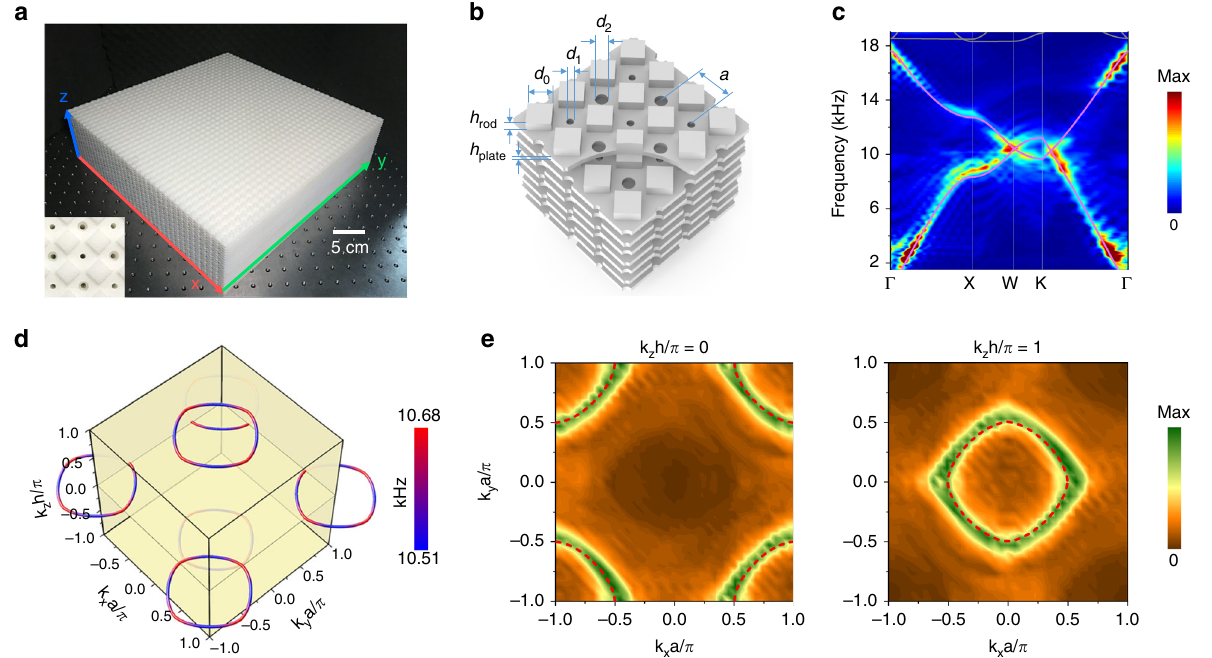
Fig. 2 Nodal rings for sound waves in 3D phononic crystals. a Photograph of the 3D sample, with an enlarged front-view shown in the inset. b Schematics of a magni fi ed side view of the sample, which is constructed by layered stacking structures. The thickness of the plate h plate = 1.80mm in which staggered holes with diameters d 1 = 2.16mm and d 2 = 3.84mm are penetrated and among which square pillars of height h rod = 3.36mm and side length d 0 = 7.20mm are periodically arranged. The distance between the staggered holes is a = 12mm, and the total height of a single layer h = h plate + h rod . c The simulated (purple lines) and measured (colors) fi rst and second bands along the high symmetry lines in the fi rst BZ. Linear crosses occur at a frequency of approximately 10.6kHz. d Simulated nodal rings distributed in reciprocal space. The colors denote the frequency variations, which range from 10.51 to 10.68kHz. e Experimentally measured nodal rings at a frequency of 10.6kHz shown at the planes k z h / π = 0 and k z h / π = 1, which agree with the simulated data (marked by red dashed curves)